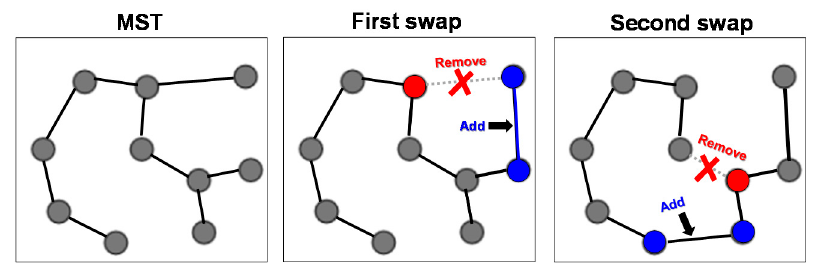
Figure 11. Results of the various algorithms for the toy example.